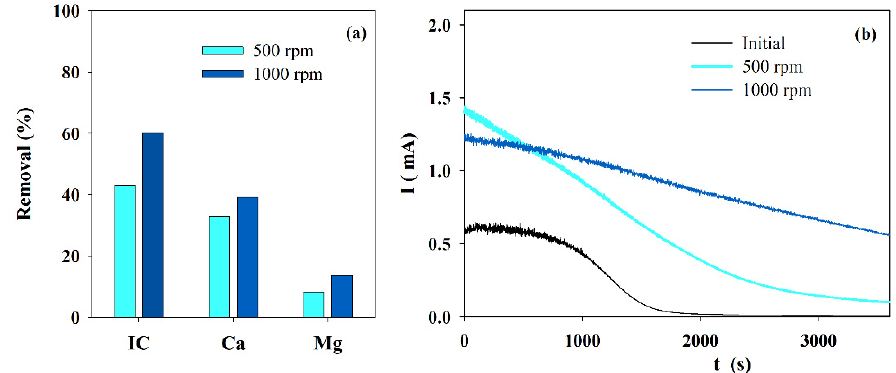
Figure 1. Influence of the stirring speed on the ( a ) IC, Ca 2+ and Mg 2+ removals, during electrolysis (I = 0.1 A; Anode—BDD 20 cm 2 ; Cathode—SS 10 cm 2 ; 4 h), and ( b ) chronoamperometric tests (E = − 0.96 V vs. Ag/AgCl) run with S solution before and after the electrolytic assays performed at different stirring speed.